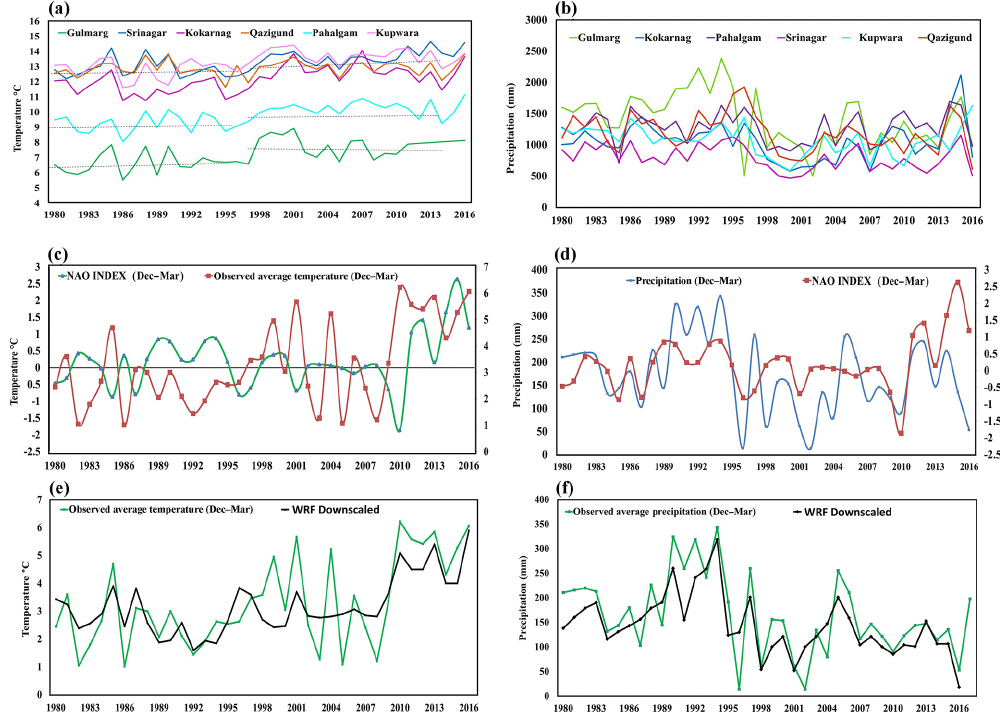
Figure 4. (a) Cumulative testing for defining change point of temperature (averaged for all six stations of the Kashmir valley), (b) same as (a) but for precipitation, (c) comparison of trends of Kashmir temperature with North Atlantic Ocean (NAO) index, (d) same as (c) but for precipitation, (e) regression analysis of winter temperature and (f) regression analysis of winter